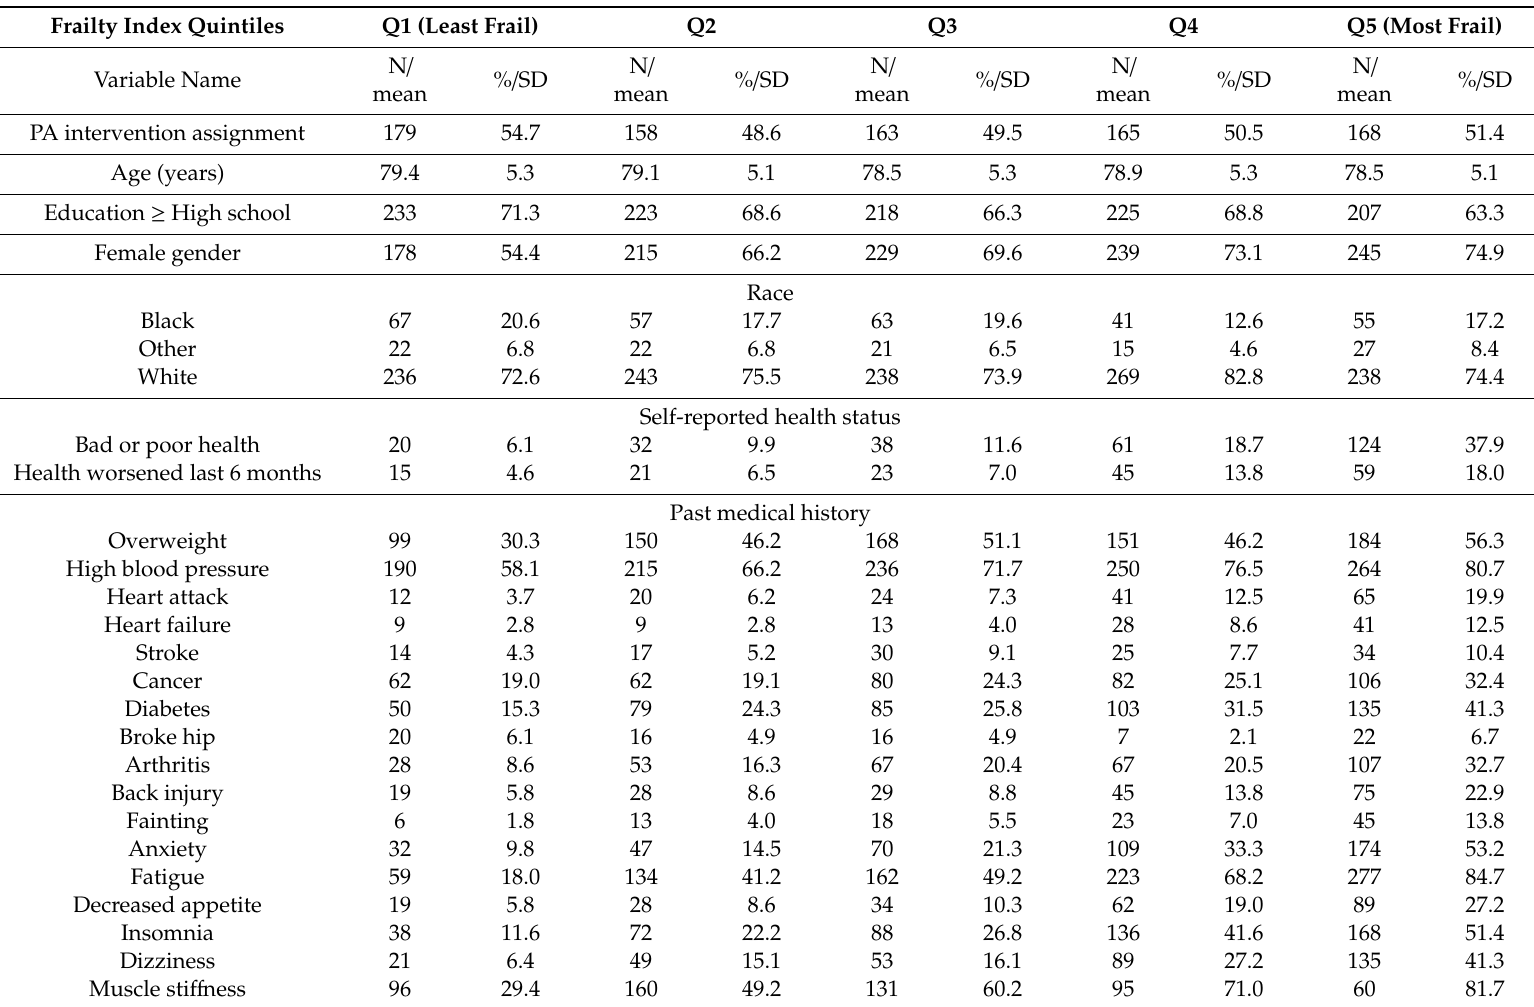
Table 1. Distributions of baseline demographics, clinical characteristics, and physical assessments stratified by quintiles of the frailty index. Frailty Index Quintiles